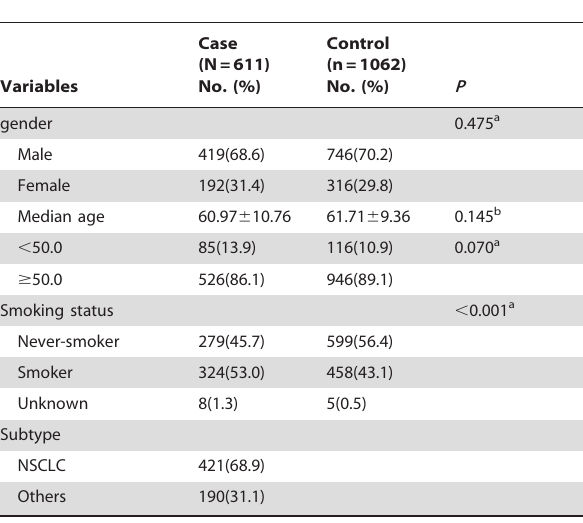
Table 1. The characteristics of our study